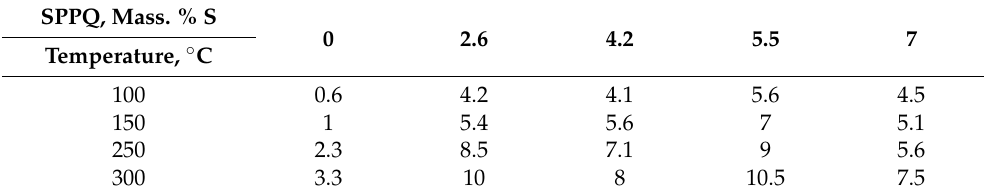
Table 1. Water content according to STA in dry film sample of SPPQ (humidity 20 rel. %) in mass. %. SPPQ, Mass. % S